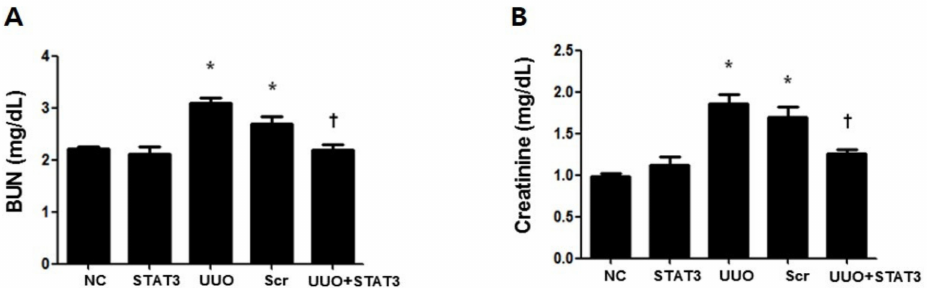
Figure 2. Inhibition of UUO-induced Kidney Damage by STAT3 Decoy ODNs. The effects of STAT3 decoy ODN on level of kidney function after UUO. ( A ) The Urea Nitrogen (BUN) assay, ( B ) the Creati- nine analysis. The results are expressed as means ± SE of three independent determinations * p < 0.05 vs. NC, † p < 0.05 vs. UUO. Abbreviations: UUO, unilateral ureteral obstruction; decoy ODNs, decoy oligonucleotides; STAT3, signal transducer and activator of transcription 3; Scr,